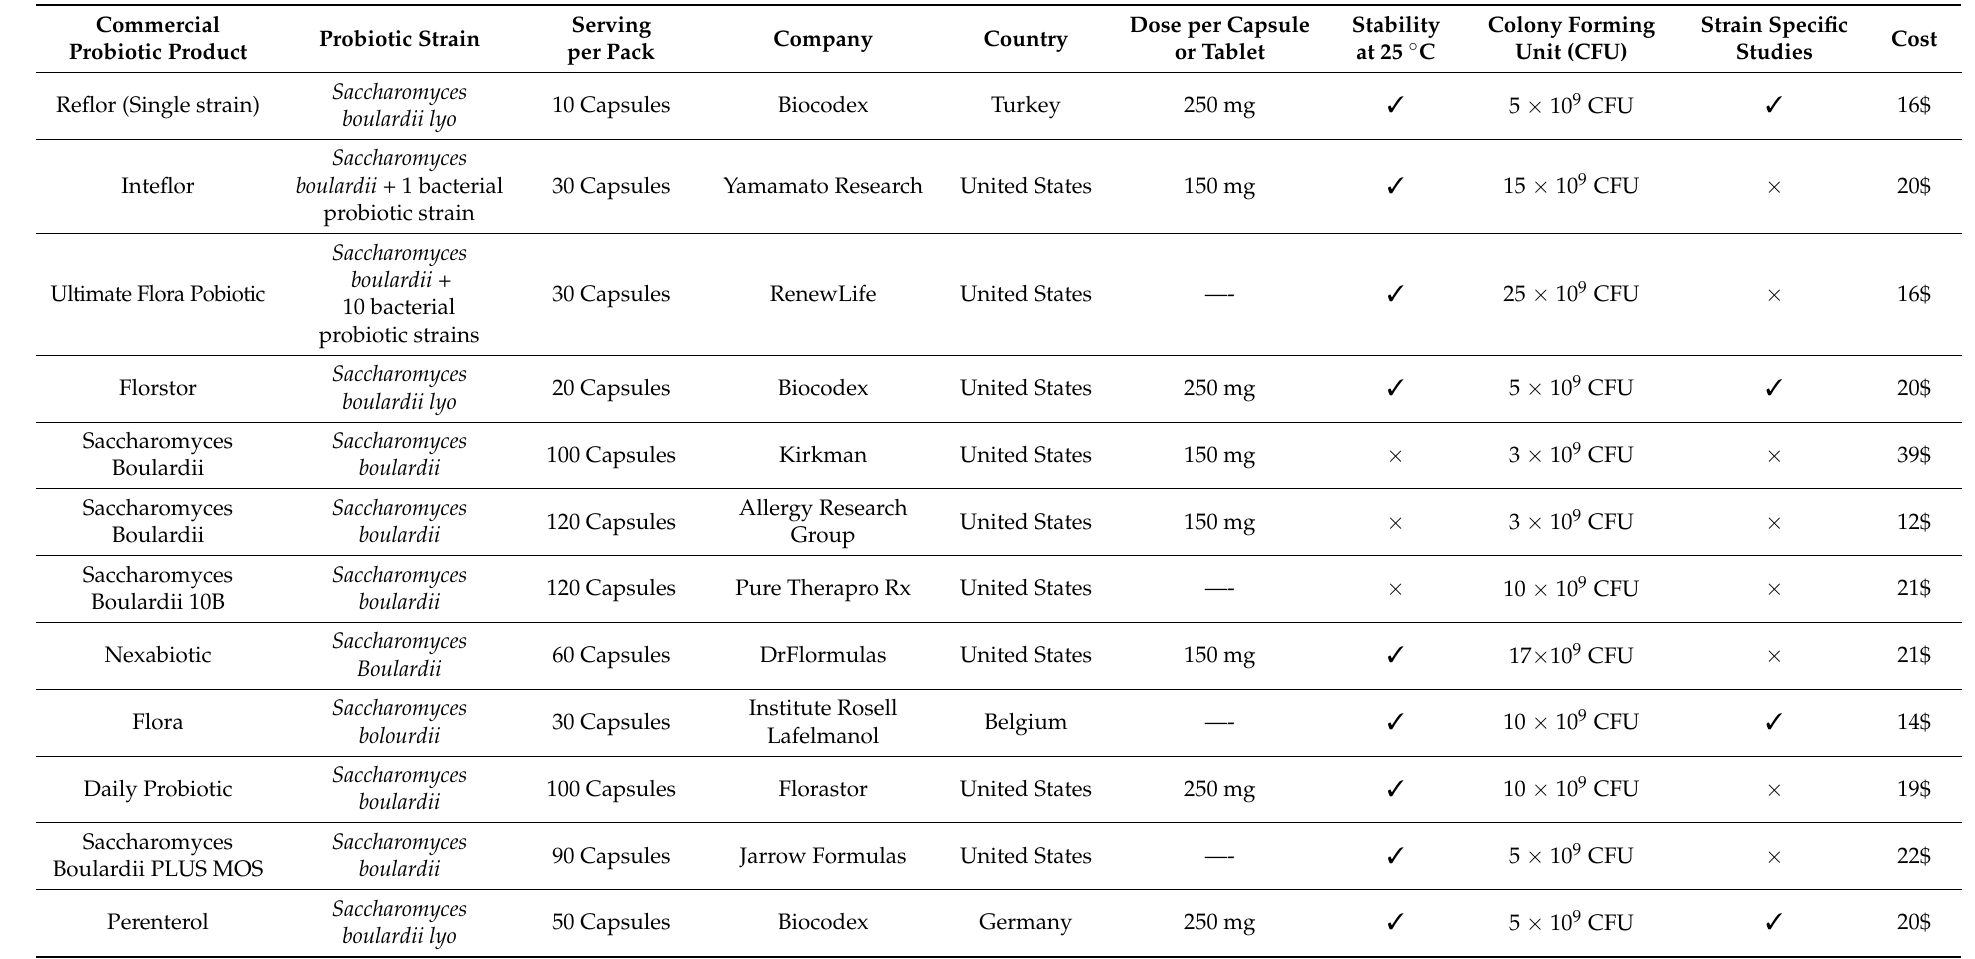
Table 1. Commercially available probiotic yeast